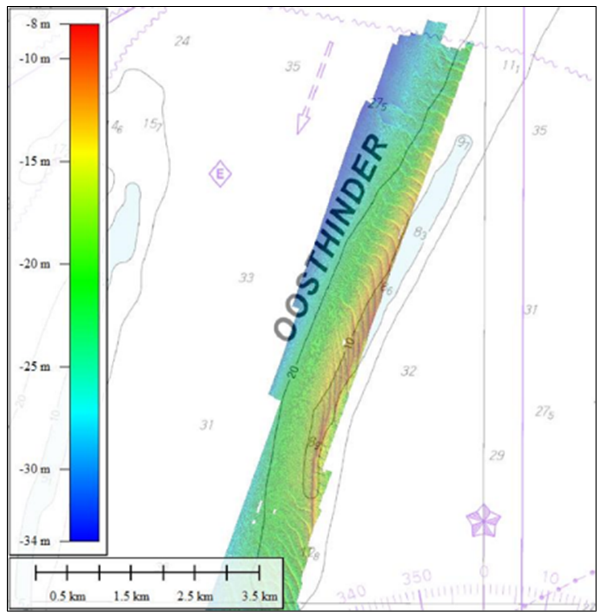
Figure 3. Graphic visualisation of the bathymetric model of the Oosthinder sandbanks, as measured in July 2019